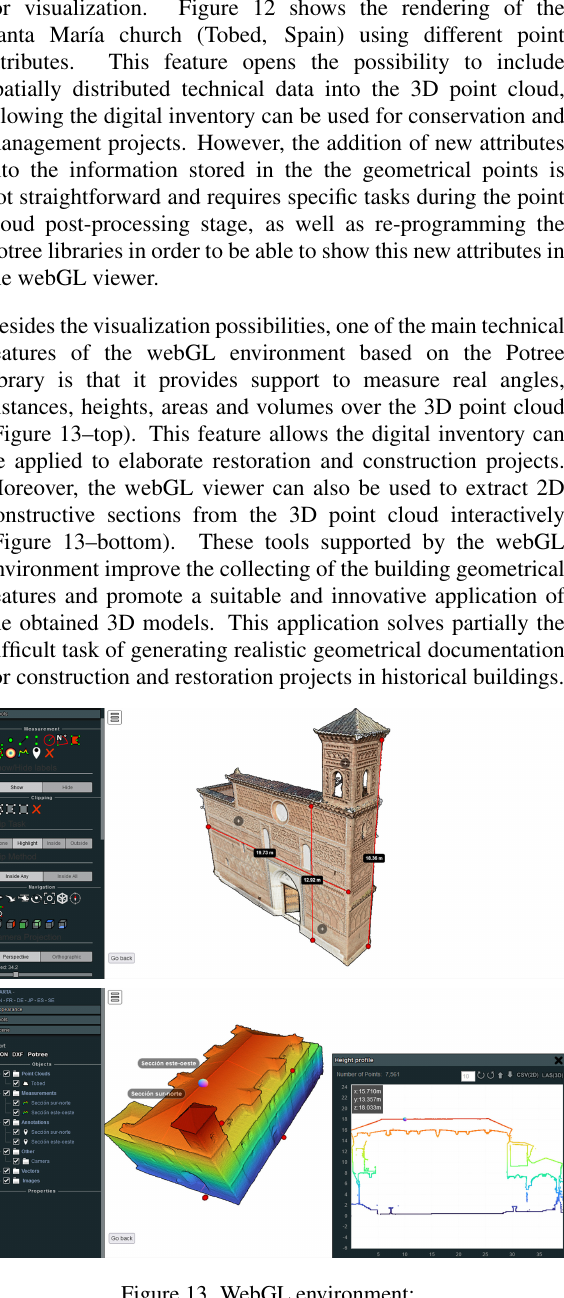
Figure 13. WebGL environment: .